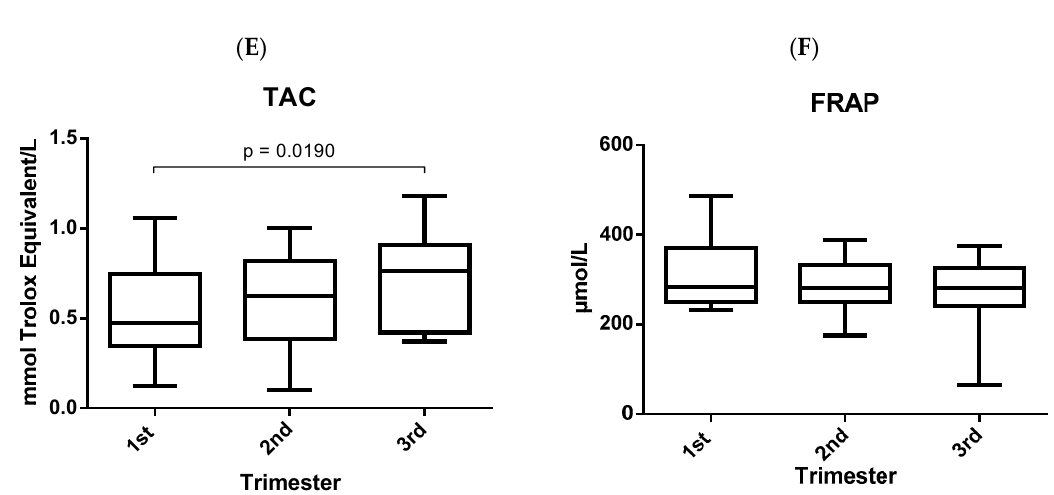
Figure 3. Antioxidant defenses in the three gestational trimesters. P-SH, NP-SH, vitamin C, TAC, and FRAP were analyzed by Kruskal-Wallis and represented as median with interquartile range. Catalase was analyzed by ANOVA followed by Tukey’s test and represented as mean with standard deviation.